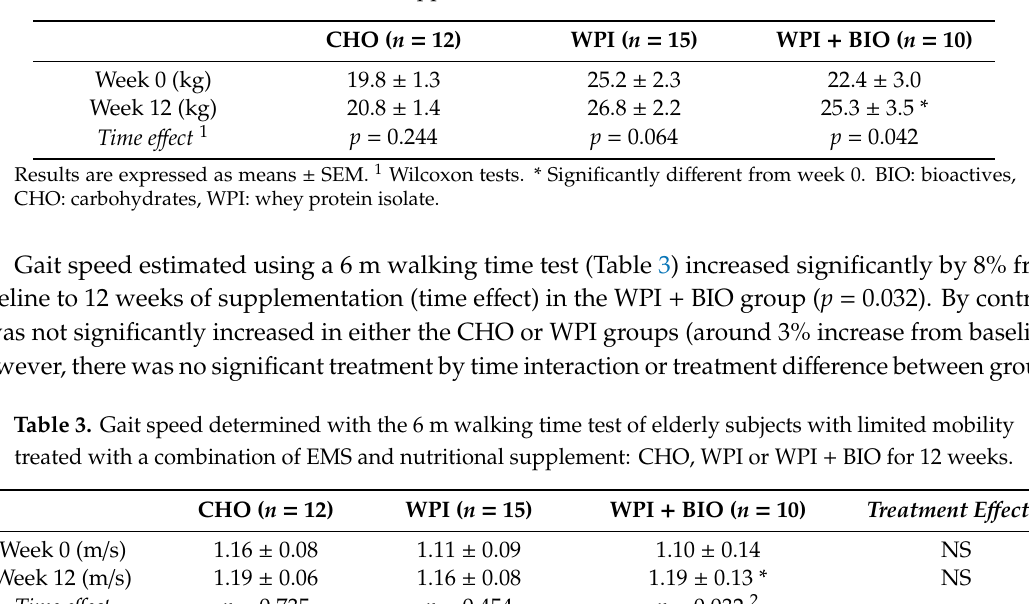
Table 2. Muscle knee extension strength of elderly subjects with limited mobility treated with a combination of EMS and nutritional supplement: CHO, WPI or WPI + BIO for 12 weeks.